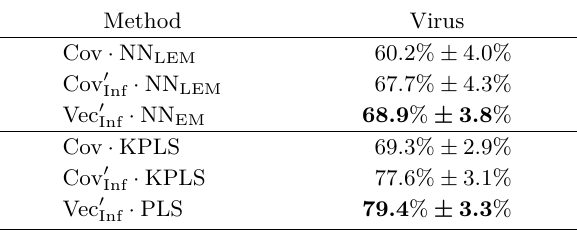
Table 2 Classification accuracies for the Virus dataset